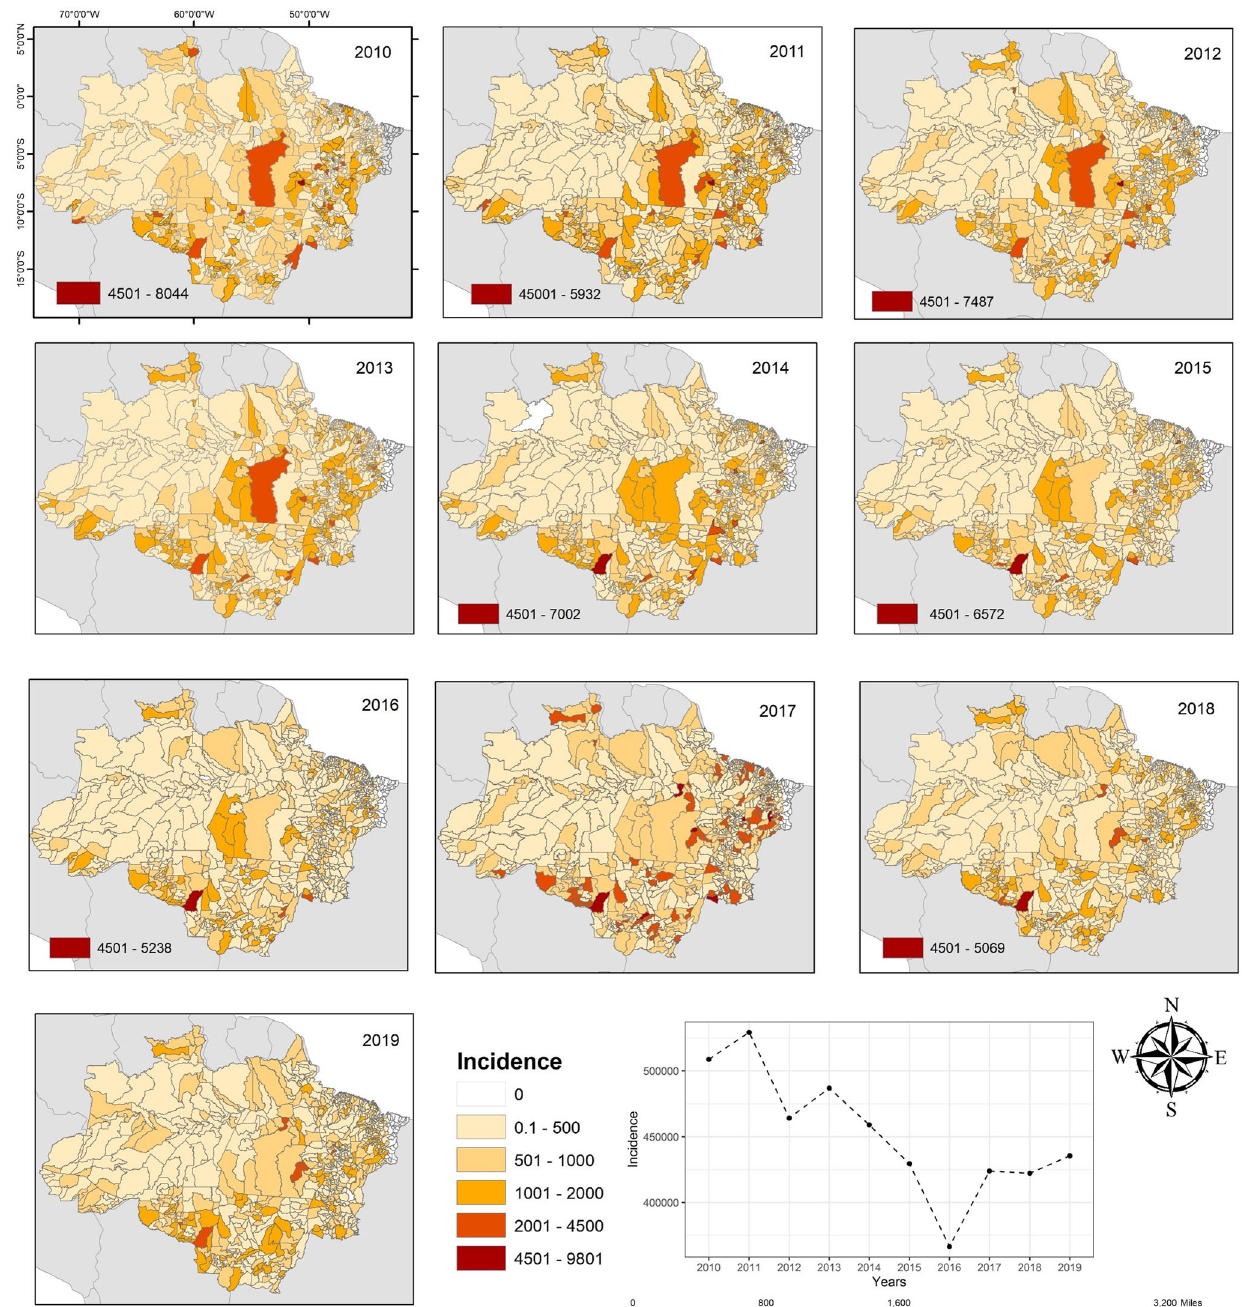
Fig. 2 Fire-related disease incidence. Incidence of respiratory and cardiovascular diseases and infections for the entire Legal Amazon on a municipality basis from 2010 to